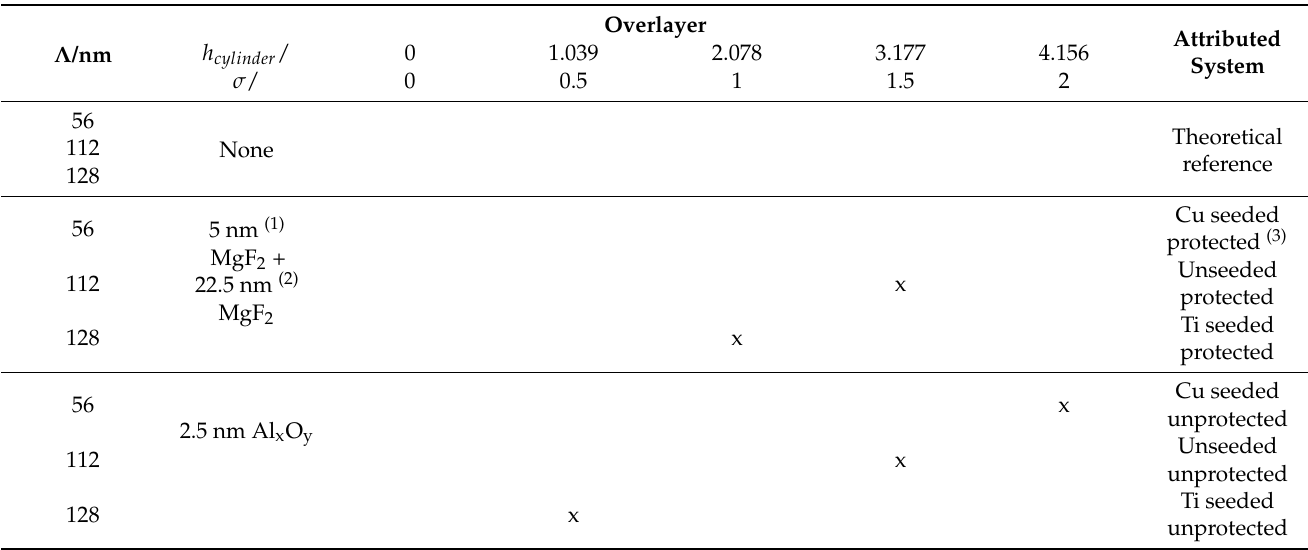
Table 2. Correspondence between simulated systems and real